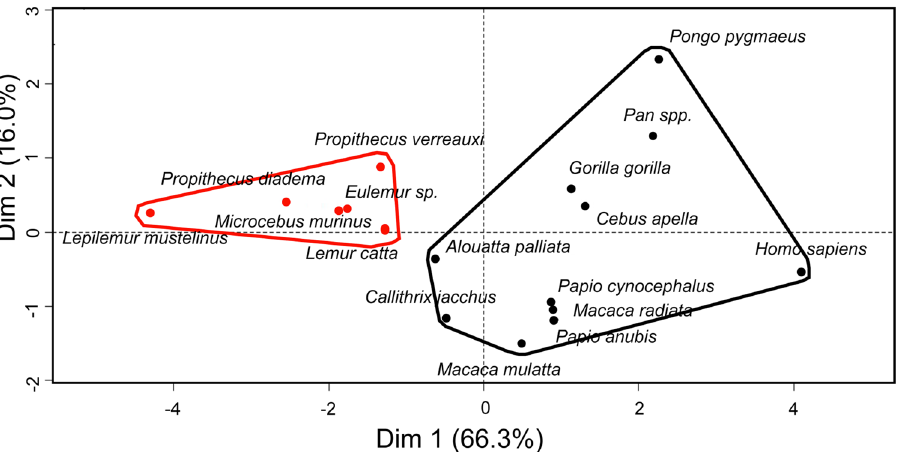
Figure 3. Principal component analysis showing taxonomic distinction of selected lemurs (red filled circle) from other primates (black filled circle), based on life history traits and brain size (see Table 1) when the effect of body mass is removed. Data for these species are residuals from a regression on body mass of each of the life history characteristics in a large primate sample (n = 87 spp. including humans, see Text). Dimension 1 loads positively on brain size, prenatal growth, age at first reproduction, maximum lifespan, reproductive output, and reproductive duration. Dimension 2 loads positively on reproductive duration, and negatively on reproductive output. The graph was generated using R 64 . A biplot of the species graph and variables graph is found in Supplementary Fig. S1